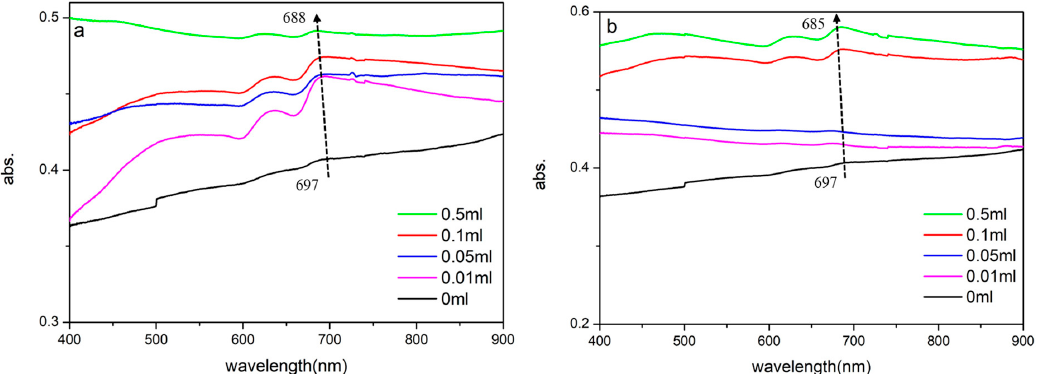
Figure 4. UV-Vis spectra: ( a ) MoS 2 -ethanethiol and ( b ) MoS 2 -nonanethiol.